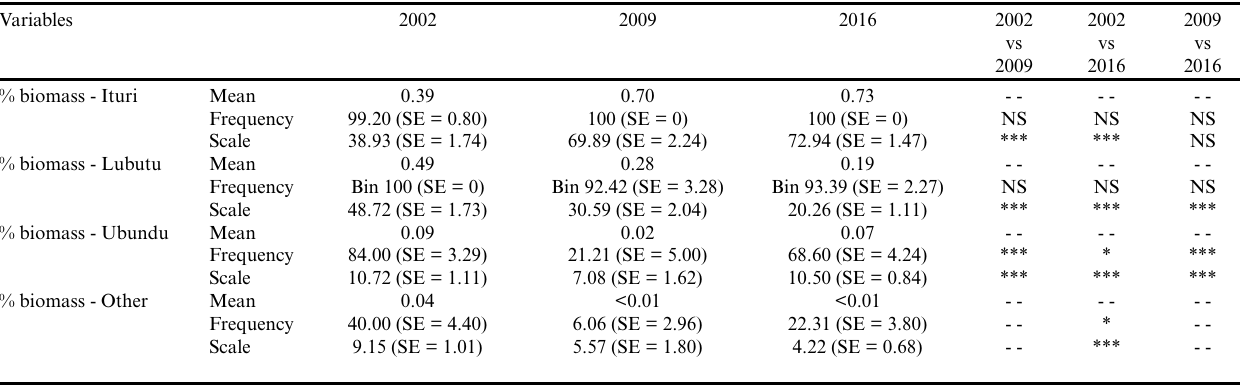
Table 5 . Percentage of total biomass entering the Kisangani market along different trade routes showing the percentage of sampling days bushmeat was recorded arriving from each trade route (frequency) and the total daily biomass recorded per route on days when trade on a route was recorded (scale). (- - = not applicable, NS = nonsignificant, * = p < 0.05, ** = p < 0.01, *** = p < 0.001 ) Variables